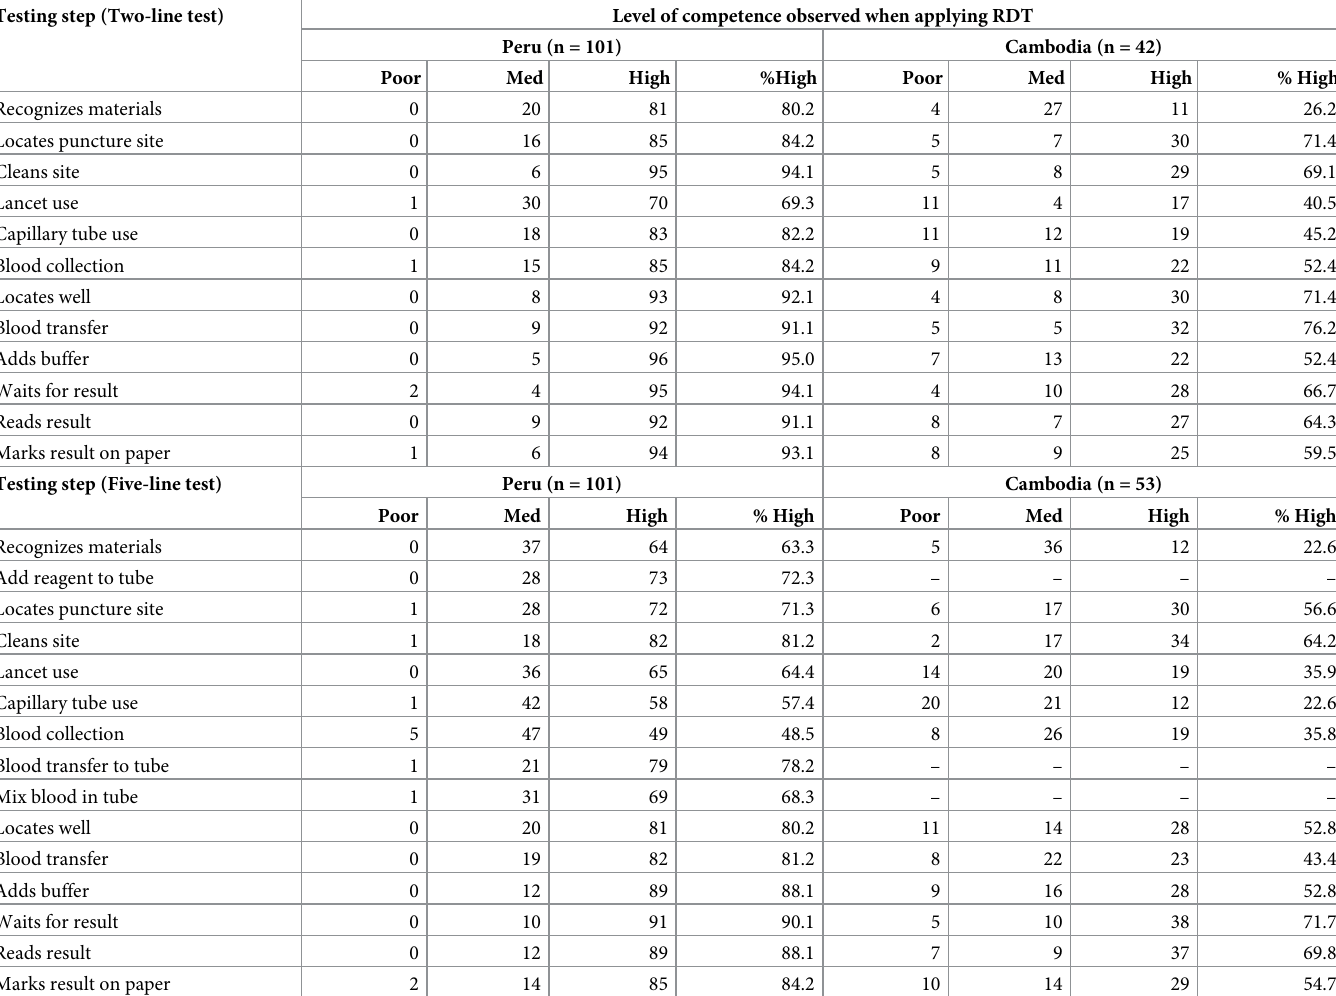
Table 2. Observations of community members’ competency applying two rapid diagnostic tests (two-line, five-line) in Iquitos, Peru and Phnom Penh, Cambodia. The number of participants scored in each competency category, high = 3, medium (med) = 2, and poor = 1, are shown for each testing step. Testing step (Two-line